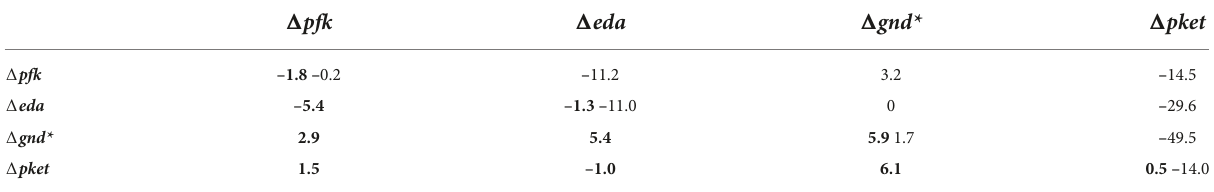
TABLE 3 Simulated growth rate changes (%) caused by single and double mutants of marker glycolytic enzymes under autotrophic and mixotrophic conditions.